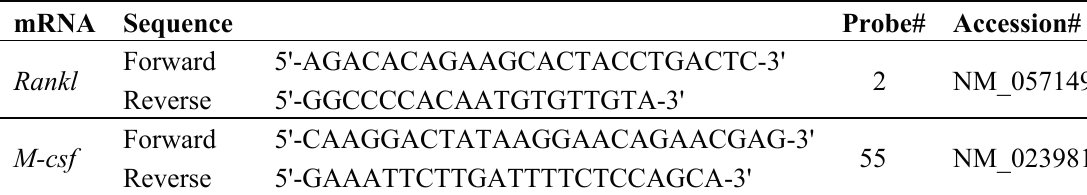
Table 1. Primers and probes for qPCR